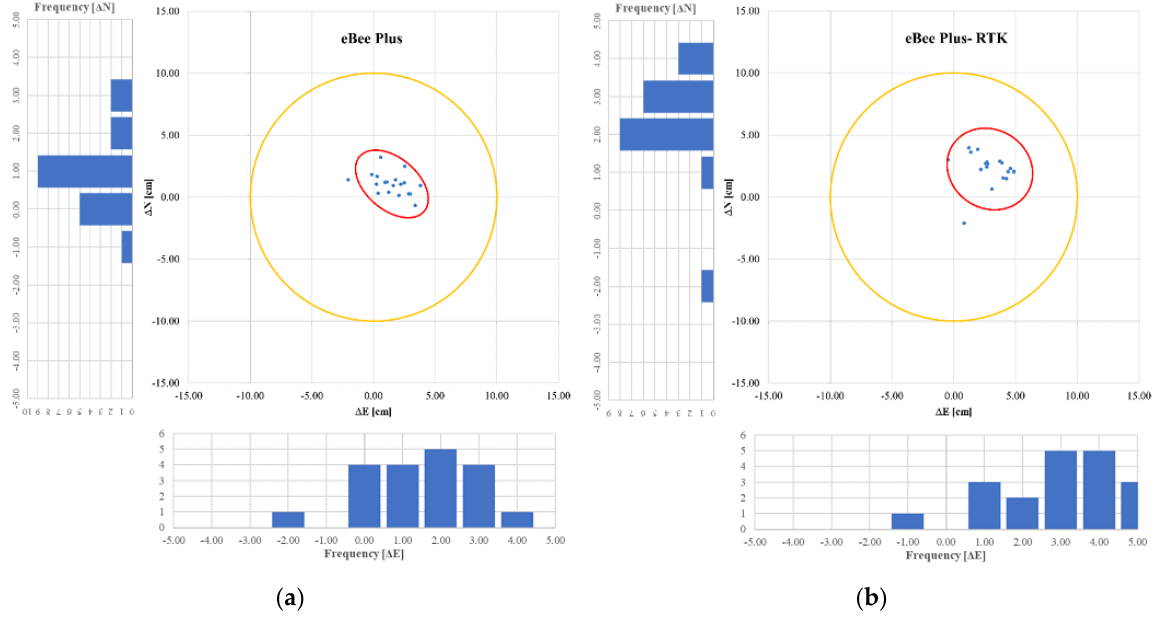
Figure 10. Confidence ellipse — eBee with GCPs at 120 m ( a ); Confidence ellipse — eBee without GCPs (RTK) at 120 m ( b ). Table 4. UAS DJI Phantom 4—achieved data quality with the use of GCPs.